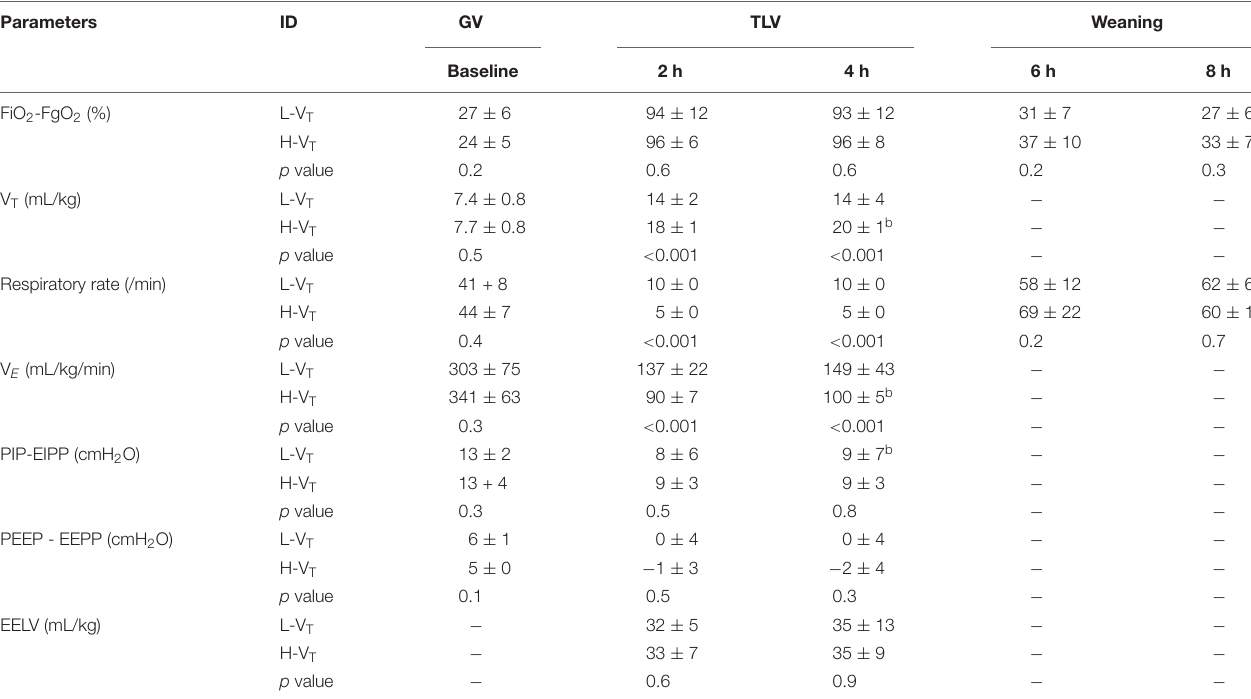
FiO 2 , fraction of inspired oxygen; FgO 2 , fraction of oxygen bubbled in PFOB in the ventilator; V E , minute ventilation; PIP, peak inspiratory pressure; EIPP, end-inspiratory pause pressure; EELV, end-expiratory liquid volume; PEEP, positive end-expiratory pressure; EEPP, end-expiratory pause pressure (TLV). See legend of Table 1 for other